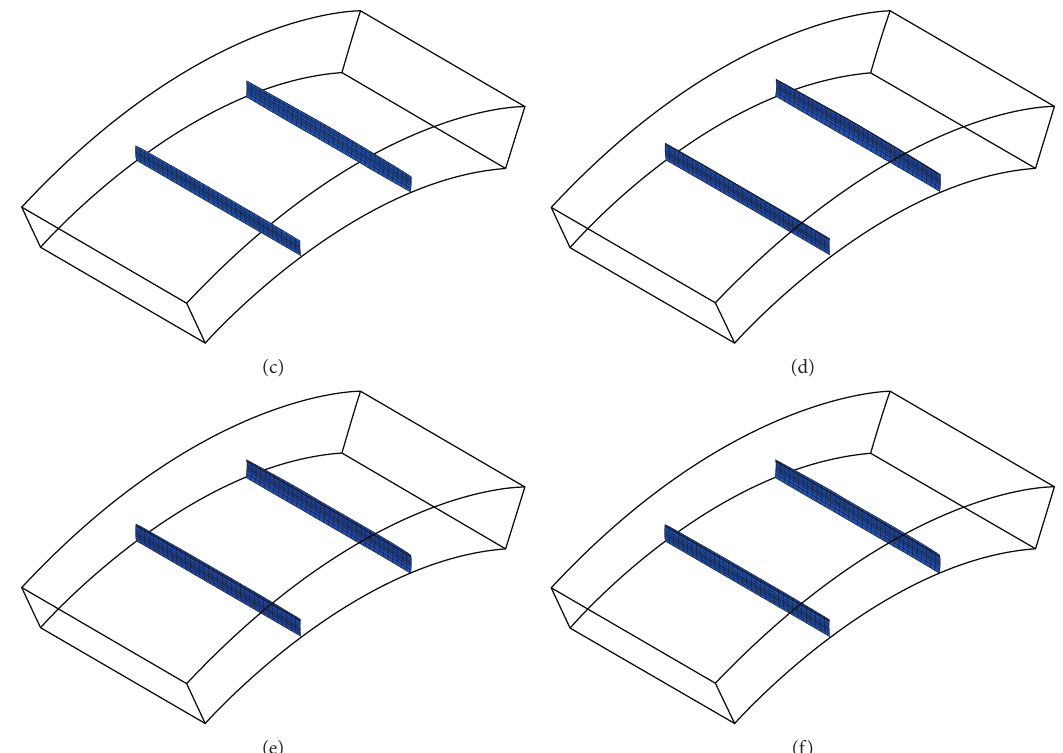
Figure 14: Fatigue-crack propagation of the segment under cyclic loading, a 3D view.